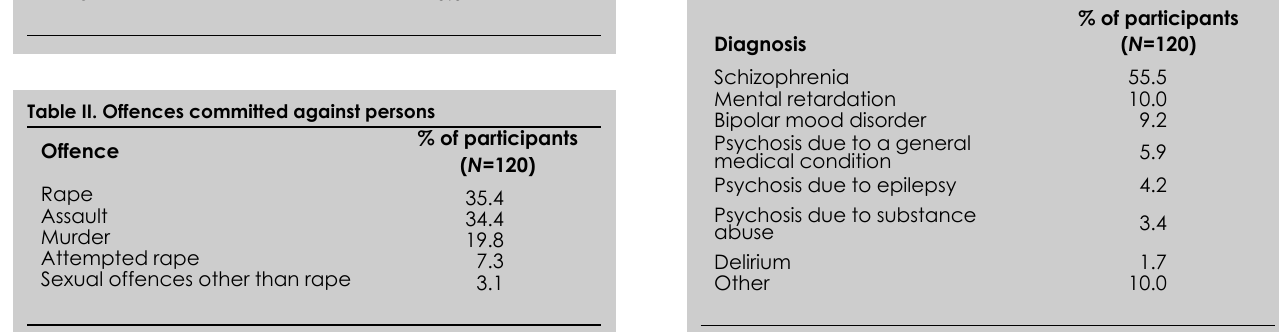
Table IV. Psychiatric diagnoses of